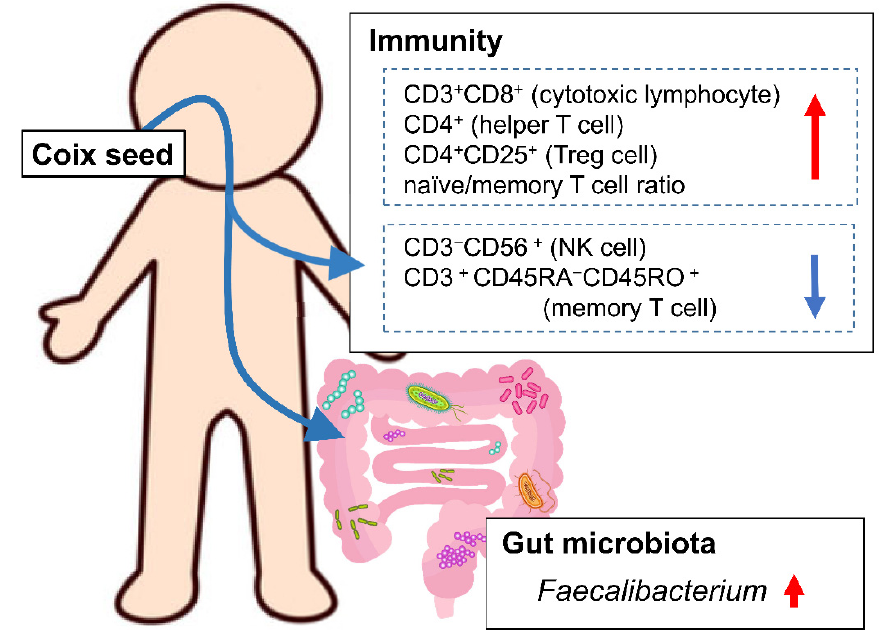
Figure 6. Summary of the results. The one-week consumption of coix seed increased the gut Faecalibacterium abundance, the relative peripheral CD3 + CD8 + (killer T cell), CD4 + (helper T cell), and CD4 + CD25 + (Treg cell) percentages, as well as the naïve/memory T cell ratio, and decreased the relative peripheral CD3 − CD56 + (NK cell) and CD3 + CD45RA − CD45RO + (memory T cell) percentages.